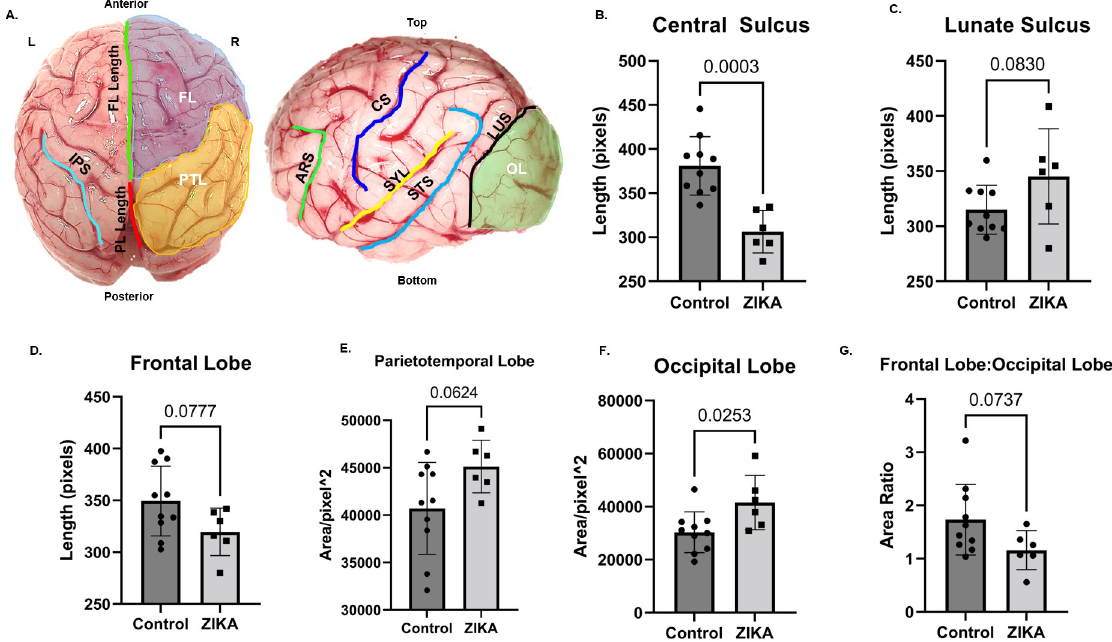
Fig 4. Differences in sulcal length and cerebral lobe surface area in brains from fetuses from early and mid-gestation ZIKV inoculated dams compared to controls. Image showing lengths of different sulcis and surface areas of different cerebral lobes measured using Image J ( A ). Measurements of CS, ARS, SYL, STS, LUS length and OL surface area were done on left hemisphere image (side view) of each brain. Measurements of right and left IPS length, FL and PTL surface areas were done on top view image of the brain. FL length was measured by drawing a line from tip of the frontal lobe to CS ( A , top view, green line) and PL length was measured by drawing a line from CS to LUS ( A , top view, red line). Significant decrease in length of central sulcus ( B ) and increase in surface area of Occipital lobe ( F ) was seen in fetal brains from ZIKV inoculated dams compared to control brains (n = 10). In fetal brains from ZIKV inoculated dams, a trend towards reduction in frontal lobe length ( D ), in frontal lobe to occipital lobe area ratio ( G ) and increase in length of lunate sulcus ( C ), and in surface area of parieto-temporal lobe surface area ( E ) was seen compared to control brains. (Error bars depict SD, unpaired t -test, p < 0.05 considered significant). Frontal Lobe (FL), Occipital Lobe (OL), Parietal Lobe (PL), Parieto Temporal area (PTL), Left Cerebral Hemisphere (L), Right Cerebral Hemisphere (R), Arcuate Sulcus (ARS), Central Sulcus (CS), Inferior Parietal Sulcus (IPS), Lunate Sulcus (LUS), Superior Temporal Sulcus (STS), Sylvian Fissure/Lateral Sulcus